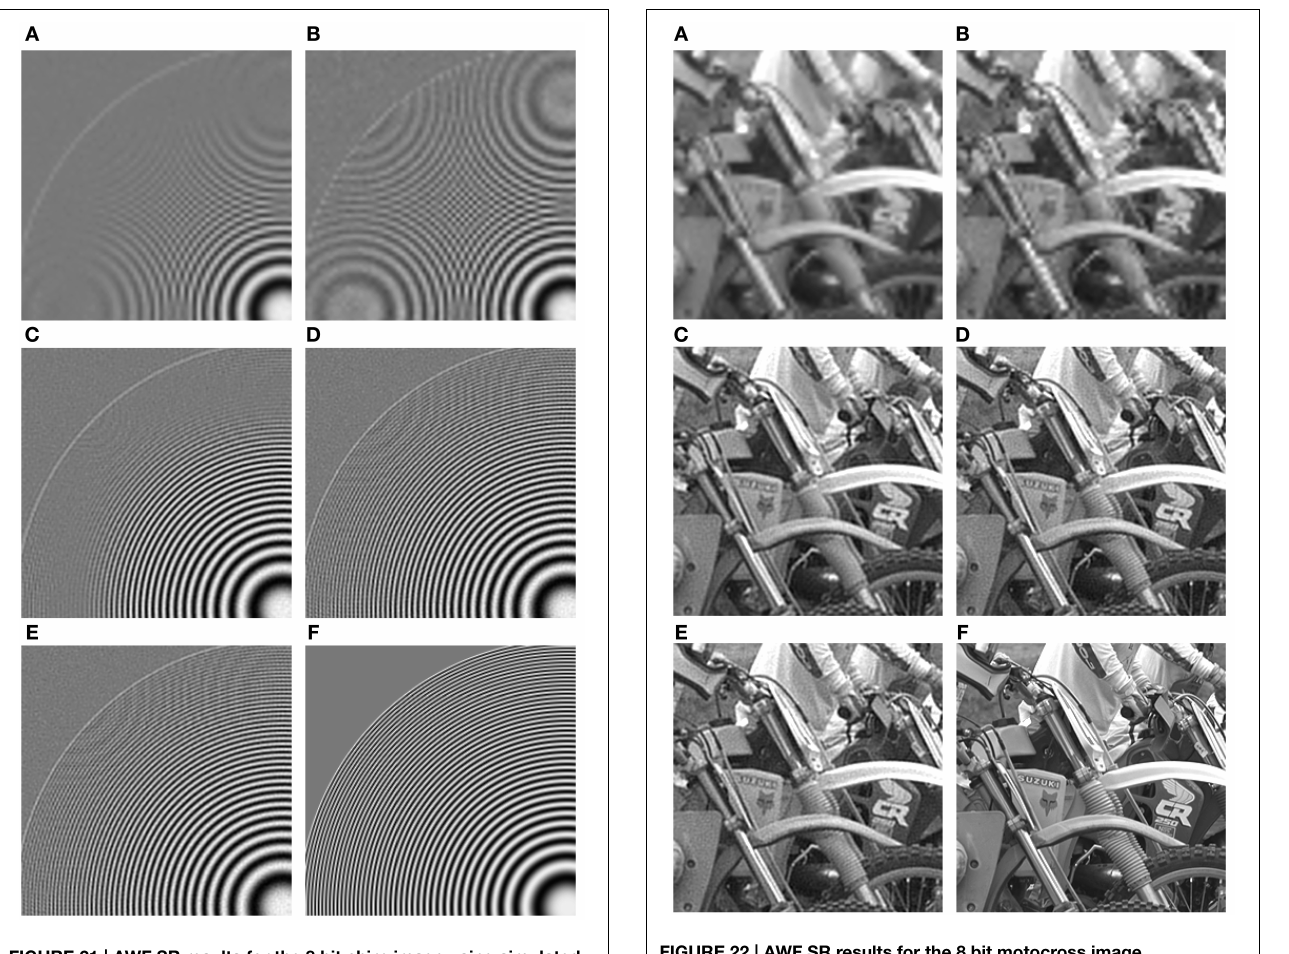
FIGURE 21 | AWF SR results for the 8 bit chirp image using simulated MWIR system with Q = 0 . 50 from Table 1 with K = 16 frames and L = 4 . (A) Bicubic interpolation of a single frame with 100% fill factor detectors ( a = 30 μ m); (B) bicubic interpolation of a single frame with 25% fill factor square detectors ( a = 15 μ m); (C) AWF SR using 100% fill factor detectors; (D) AWF SR using 25% fill square factor detectors; (E) AWF SR using 29.22% fill circular detectors ( b = 18 . 3 μ m); (F) truth image.